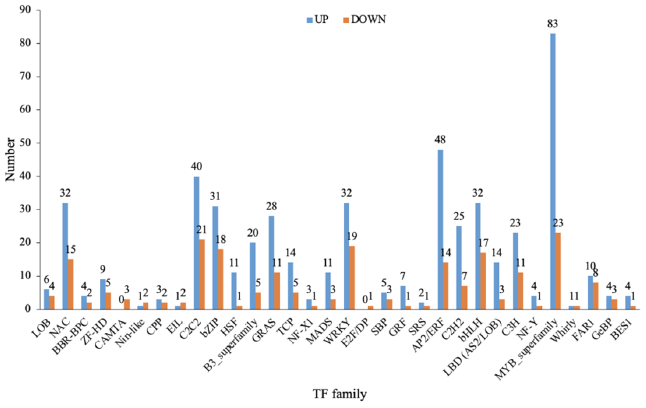
Figure 8. Differentially expressed transcription factors between T9 and CK.